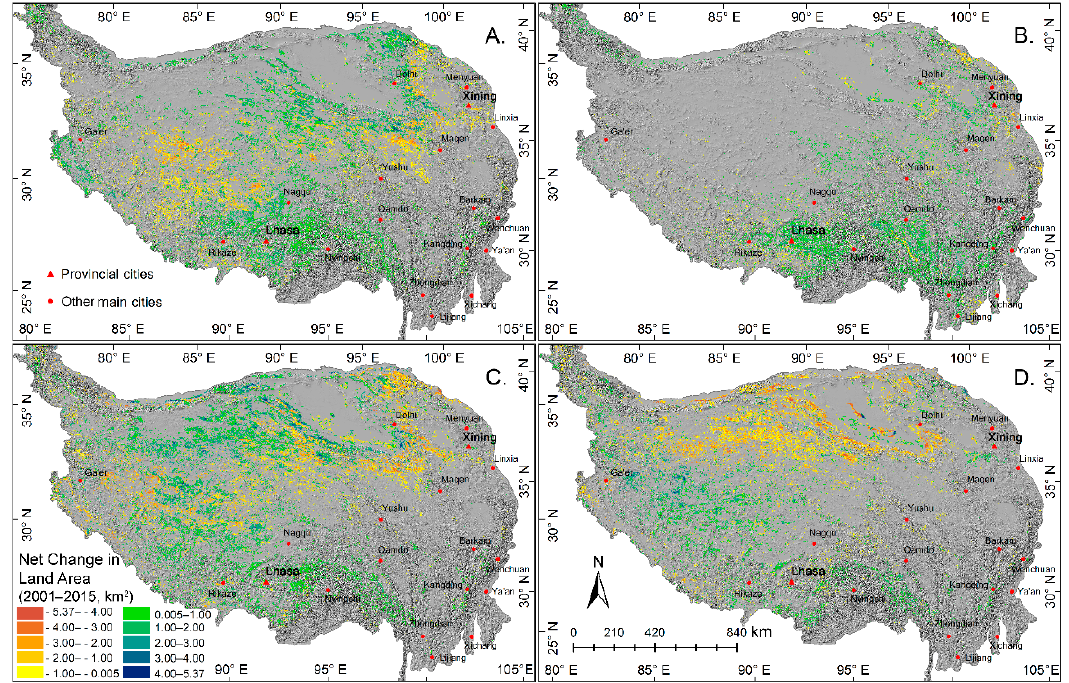
Figure 4. Sparse vegetation changes are associated with bare ground and grassland. Net changes of ( A ) steppe, ( B ) open shrubland, ( C ) sparse vegetation, and ( D ) bare ground from 2001–2015. Land changes are significant with a p -value < 0.1.